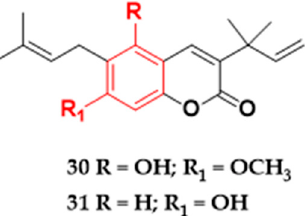
Figure 6. Coumarins with antibacterial activity isolated from plants in Brazil. Tanizin ( 30 ), and gravellifenore ( 31 ) .